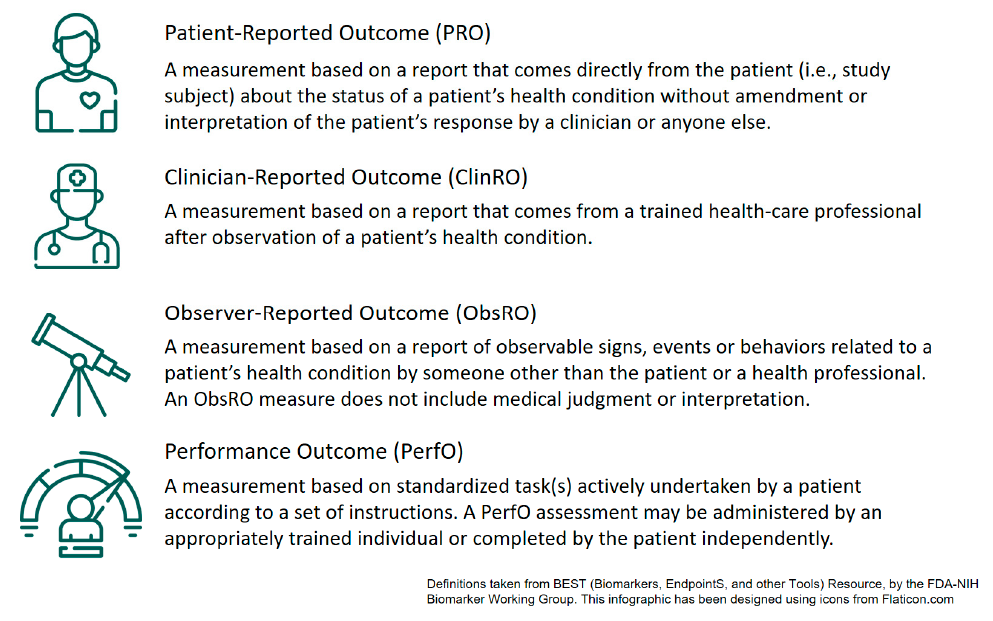
Figure 2. Different types of clinical outcome assessments (COAs).